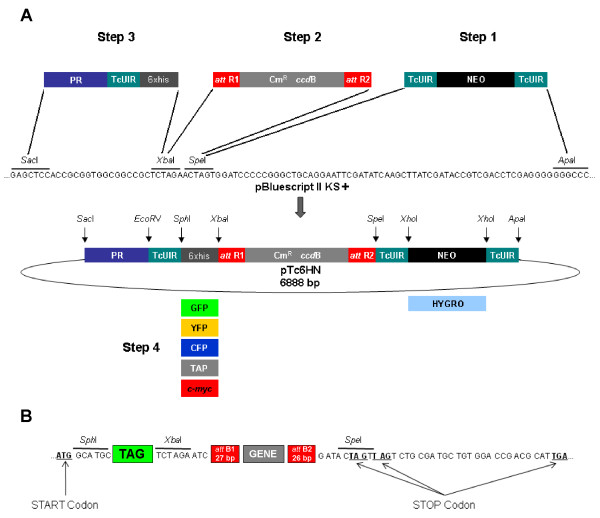
Schematic drawing showing the vector construction steps. The elements shown are the neomycin (NEO) and hygromycin (HYGRO) resistance genes, the T. cruzi intergenic region from ubiquitin locus (TcUIR), the attachment sites for Gateway(r) recombination (attB1, attB2, attR1 and attR2), the chloramphenicol resistance gene (CmR), the gene for negative selection during cloning (ccdB), the fusion tags (6xhis, GFP, YFP, CFP, TAP and c-myc) and the ribosomal promoter (PR). In A, the steps for vectors construction are represented. In B, the vector reading frame with start and stop codons are shown.